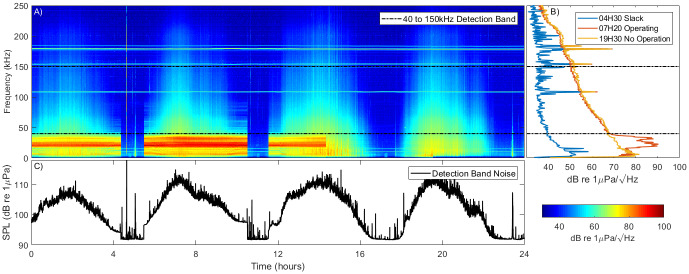
System noise over a 24 hour period.Panel A shows spectral data over the 24 hours. The four periods of tidal flow are clearly visible. Panel B shows the power spectral density at three different times during the cycle. Panel C shows the noise in the click detector detection band. The turbine operated up until 14:20 at which point generation was paused. Clearly visible are elevated noise levels at high flows over a wide frequency range. When the turbine is operating an additional noise source is evident at 20 kHz.